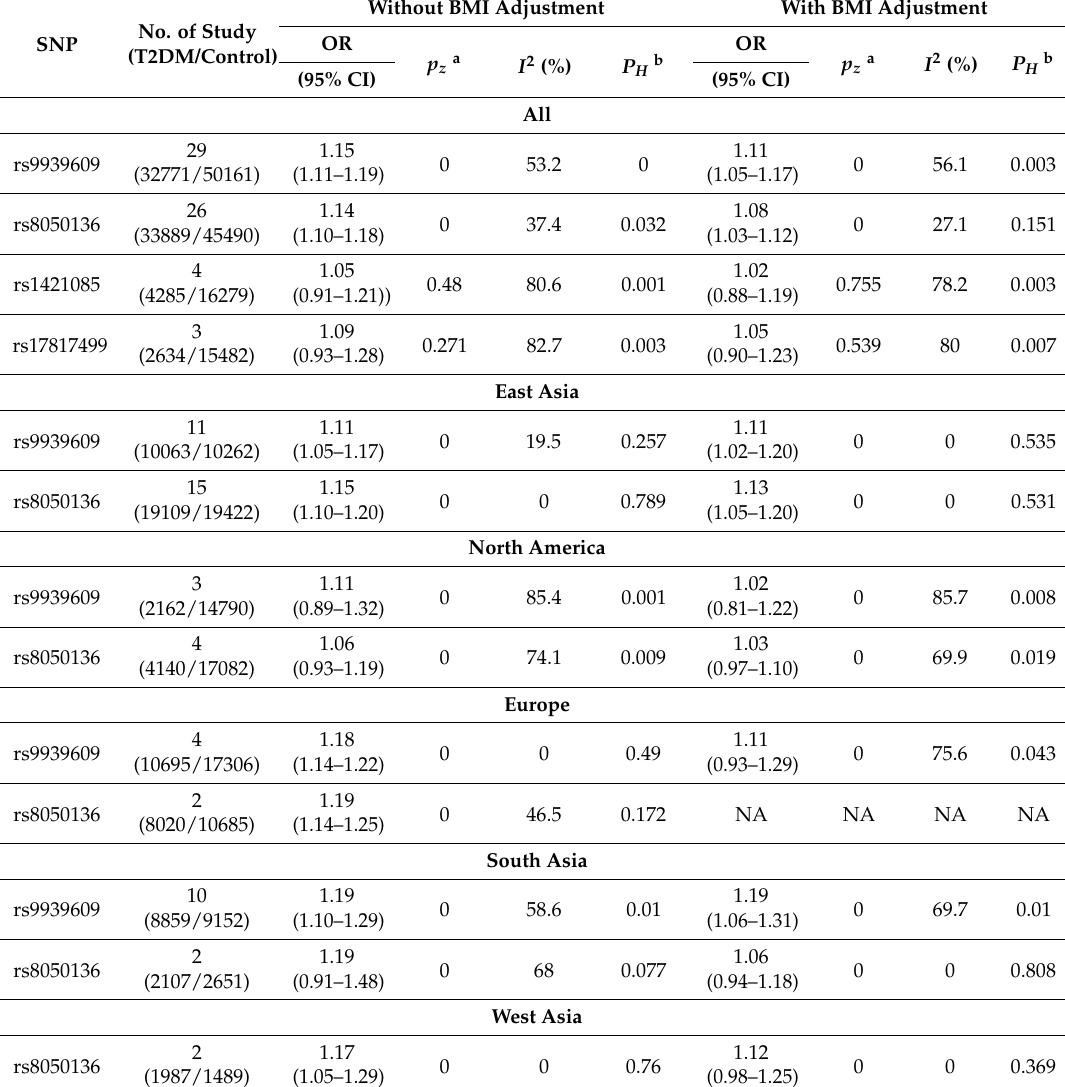
Table 2. Meta-analysis of fat mass and obesity-associated ( FTO ) single-nucleotide polymorphisms (SNPs) and T2DM